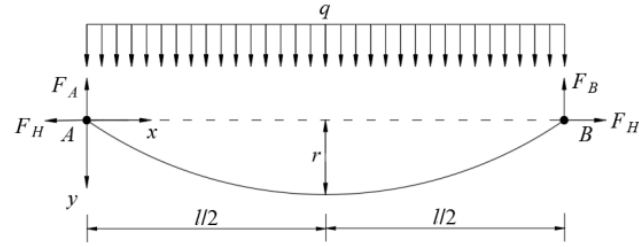
Figure 14. Geogrid deformation in pressurized zone .